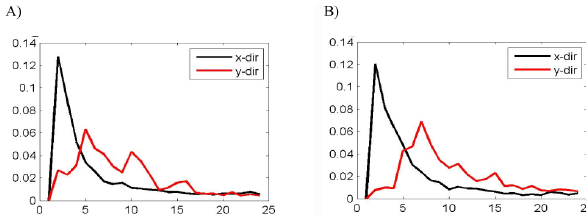
Fig. 10. Power spectral densities of the vegetation density field; fre- quencies (in the horizontal axis) are expressed in terms of num- ber of wavelengths present within the domain length and width. (A) Average of the 1-D power spectral densities of the vegetation density for the natural pattern shown in Fig. 4a along the x-direction (black line) and y-direction (red line). (B) Average of the 1-D power spectral densities of the vegetation density for the simulated pattern shown in Fig. 8c along the x-direction (black line) and y-direction (red